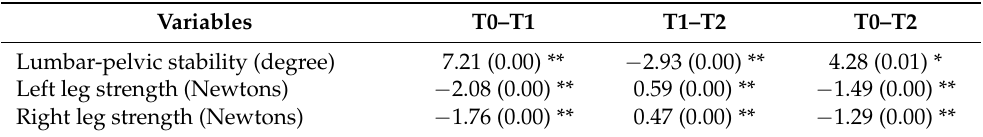
Table 5. Pairwise comparison analysis (means difference and (significance)) between the three evaluations carried out in each study